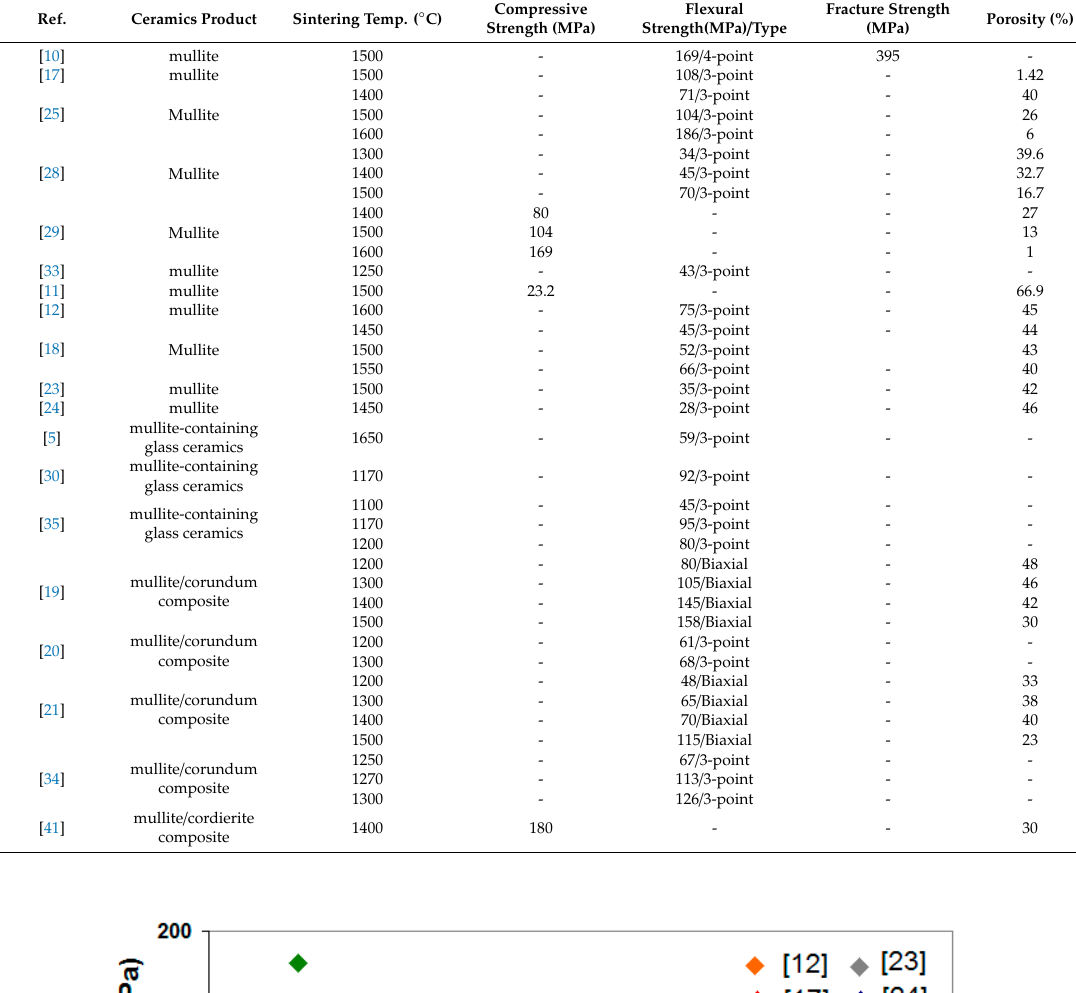
Table 3. The mechanical strengths of di ff erent mullites reported in various references. Ref.